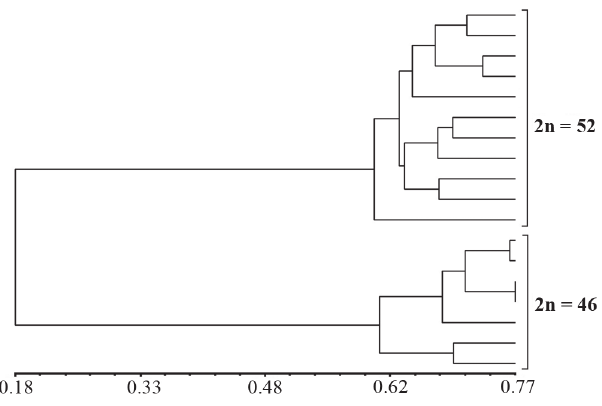
Fig. 3. Dendrogram of genetic similarity among the species of Pimelodella from the Miranda River based on the Jaccard coefficient and on UPGMA clustering method, showing the formation of two clusters.